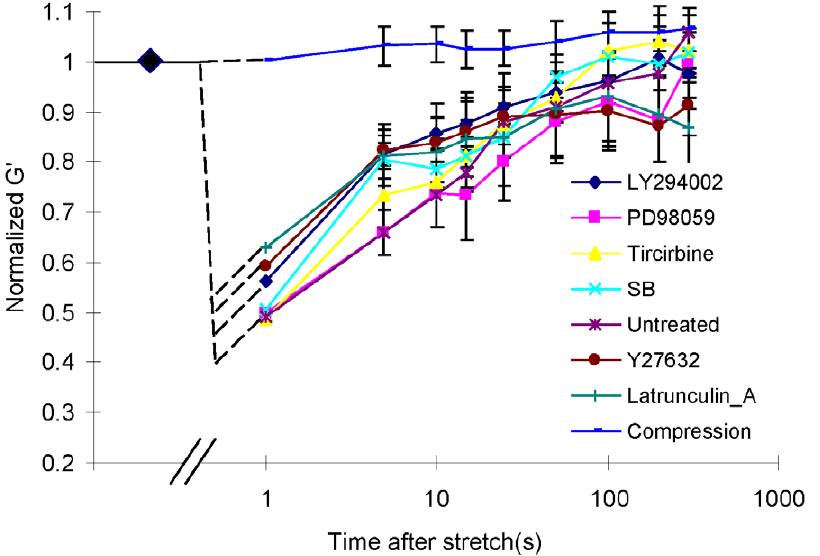
Figure 2. Stiffness dynamics in HBSM cells subjected to a transient stretch or a transient compression. In response to a transient tensile stretch, the elastic modulus G’ dropped acutely to 50–60% of its prestretch value, then recovered slowly. The rate and the extent of this fluidization- resolidification is unaffected by the addition of LY294002, Triciribine, SB2035580, PD098059, Y27632, or Latrunculin-A (p & 0.05, Kruskal-Wallis one- way analysis). When we applied to the cell a transient compression instead of a transient stretch, G’ was unchanged. All results are reported as median + SE (n=244–709 beads).